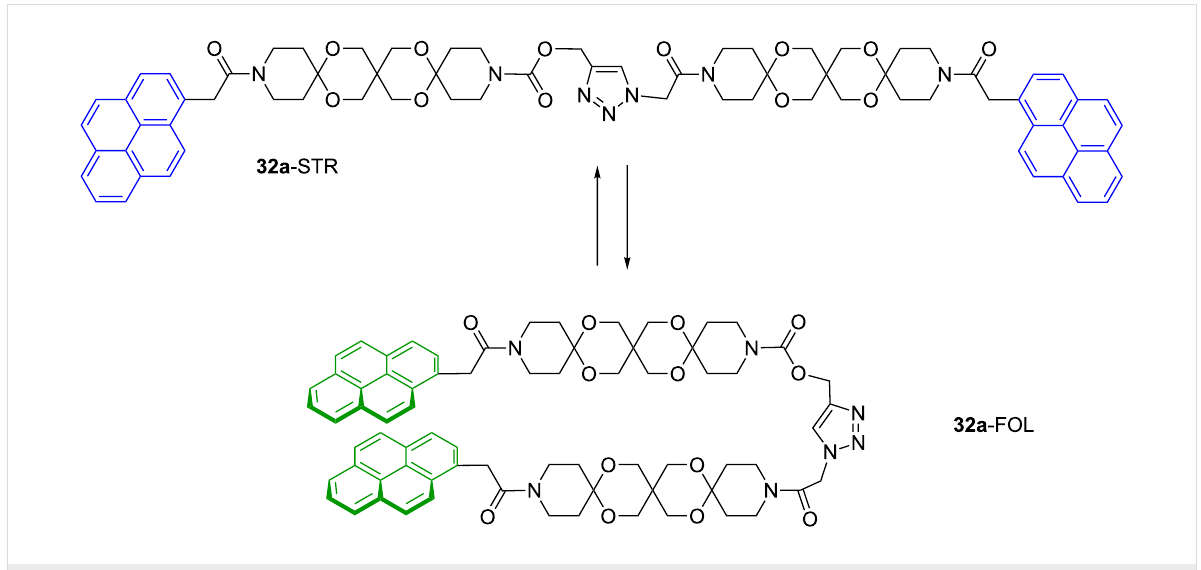
character of the excimer and suggests that the conformer 32a - STR is the global minimum. Based on these results we next investigated the I M / I EX ratio in a variety of solvents with different viscosity [26]. In Figure 5 the I M / I EX ratio is repre- sented in dependence on the viscosity η . Two nearly linear correlations are discernable. The first group (circles) with a steep slope of the correlation line corresponds to aprotic solvents, whereas the second group (triangles) with a signifi- cantly lower slope is formed by protic solvents. Obviously protic solvents substantially stabilize the folded conformation 32a -FOL. This can be understood by considering the rather hydrophobic backbone of the ARs and the markedly smaller surface of the FOL conformation. This behavior resembles folding of peptides and self-assembly of